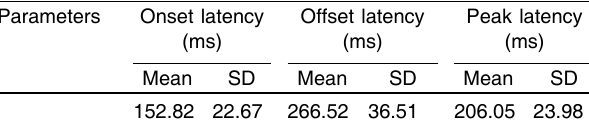
Table 1 The mean and SD of onset latency, offset latency,